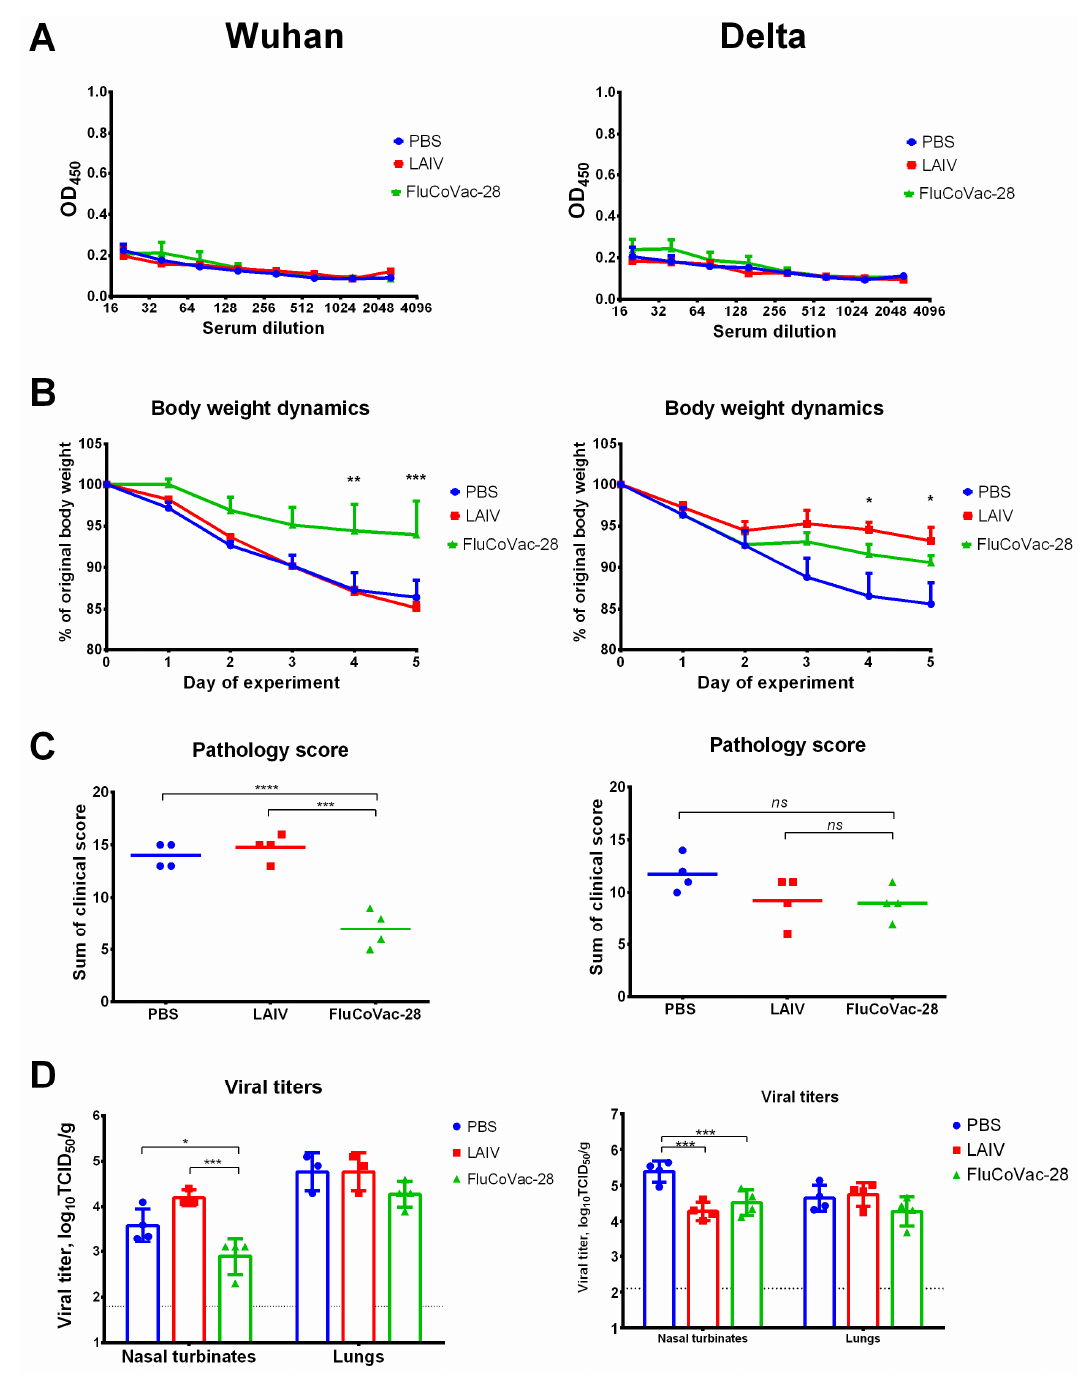
Figure 7. Humoral immunity and protective activity of the LAIV/SARS-CoV-2 chimeric virus against SARS-CoV-2 viruses in Syrian hamster model. Groups of animals were immunized twice with the indicated vaccine virus at a tree-week interval. Blood samples were collected 3 weeks post second dose, and then hamsters were challenged intranasally with 10 5 TCID 50 of SARS-CoV-2 Wuhan variant (left panel) or Delta variant (right panel). ( A ) Antibody responses to the whole SARS-CoV-2 in sera collected after two vaccine doses. ( B ) Dynamics of body weight over the challenge phase. ( C ) Sum of pathology score for 5 days post challenge. ( D ) Infectious viral titers in respiratory tissues on day 5 post challenge. Data were analyzed by two-way ANOVA with Tukey’s post-hoc multiple analyses test. *— p < 0.05; **— p < 0.01; ***— p < 0.001; ****— p < 0.0001. ns , not significant.